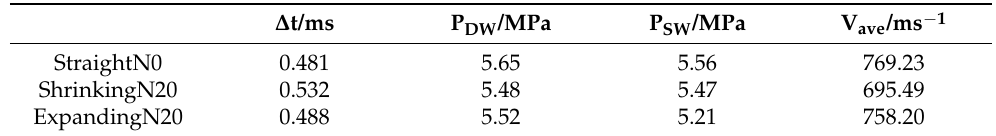
Figure 14. Curves of the pressure in the detonation tube when different nozzles are installed: ( a ) StraightN0, ( b ) ShrinkingN20, ( c ) ExpandingN20. Table 5. Characteristic parameters of shock wave in the detonation tube when different nozzles are installed.